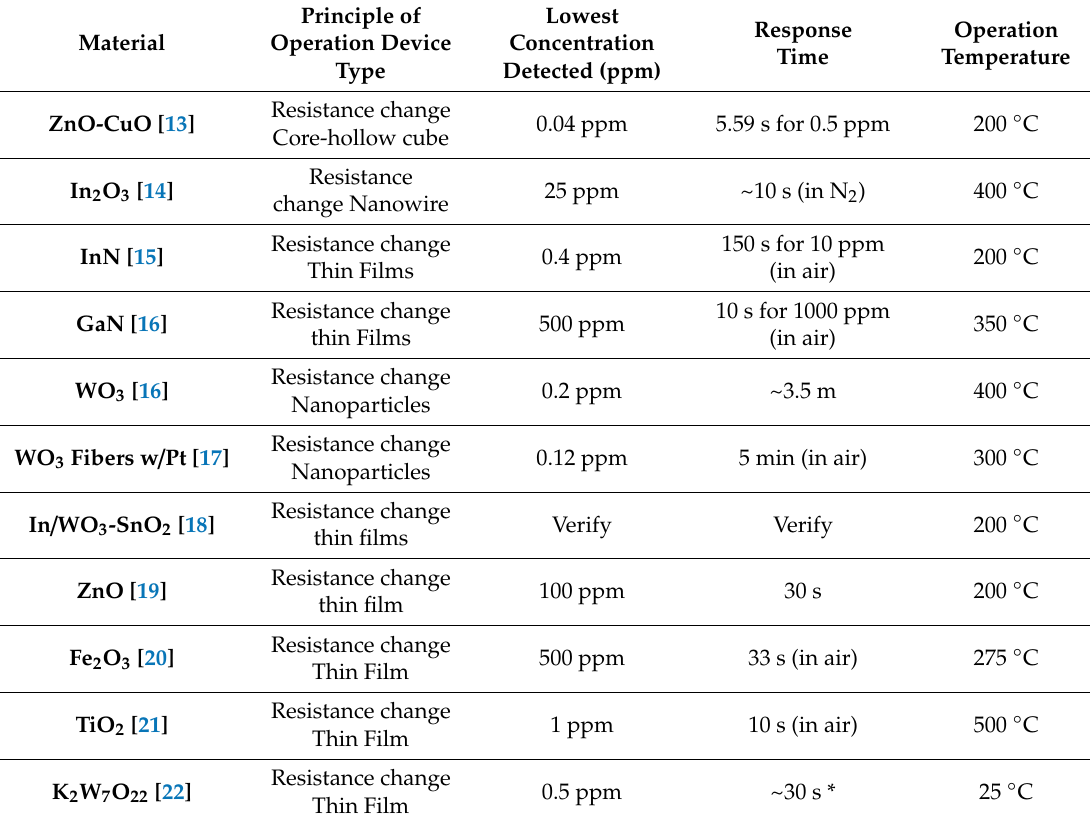
Table 1. Selected Metal Oxide Semiconductors as acetone